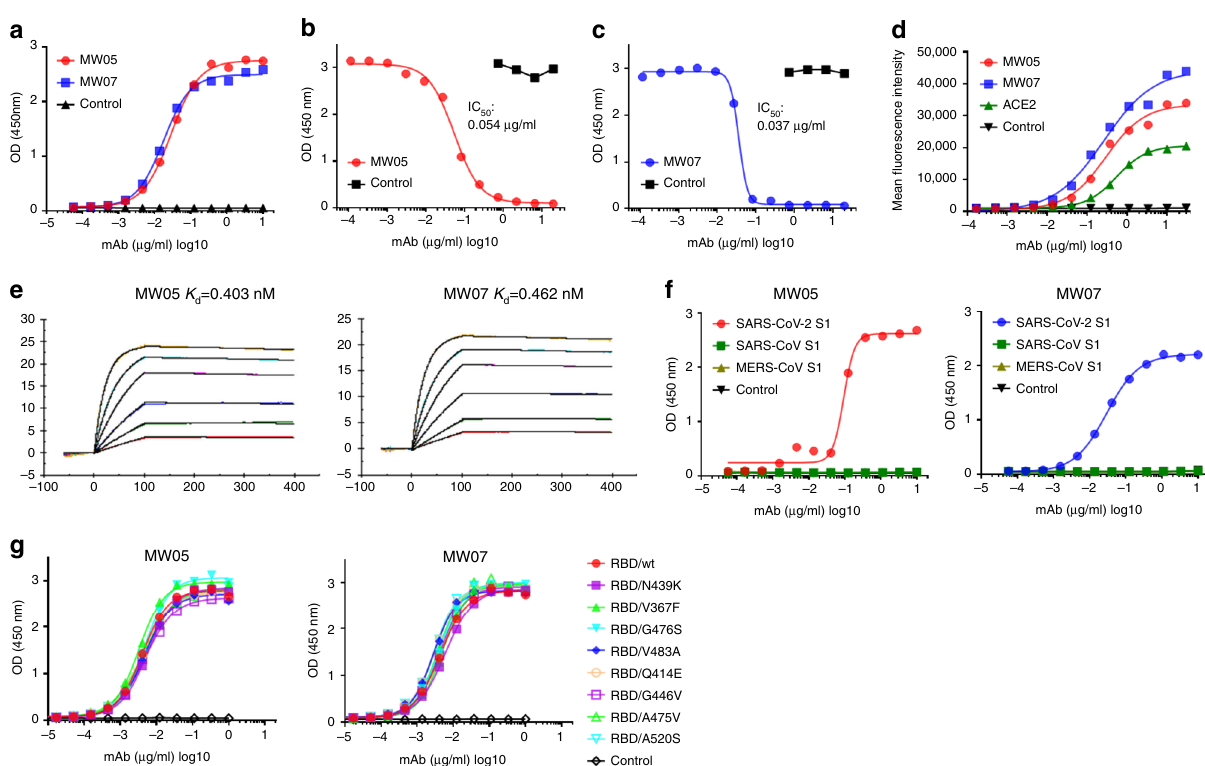
Fig. 1 MW05 and MW07 disrupting the interaction of SARS-CoV-2 RBD with hACE2 receptor. a The binding abilities of MW05 and MW07 to SARS- CoV-2 RBD recombinant protein were assessed by ELISA. b , c The abilities of MW05 and MW07 to block SARS-CoV-2 RBD interaction with ACE2 were evaluated by competition ELISA. d The binding of MW05 and MW07 to SARS-CoV-2 S protein expressed on HEK293 cells was measured by FACS. e The dissociation constants ( K d ) of MW05 and MW07 to SARS-CoV-2 S1 recombinant protein were measured using a BIAcore S200 system. f The cross- reactivities of MW05 and MW07 to SARS-CoV-CoV-2, SARS-CoV, and MERS-CoV recombinant S1 subunit of spike proteins (S1) were tested by ELISA. g The binding of MW05 and MW07 to RBD recombinant proteins of SARS-CoV-2-mutated strains.